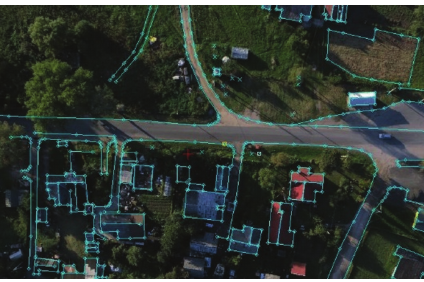
Figure 6: Topographic data of the area.